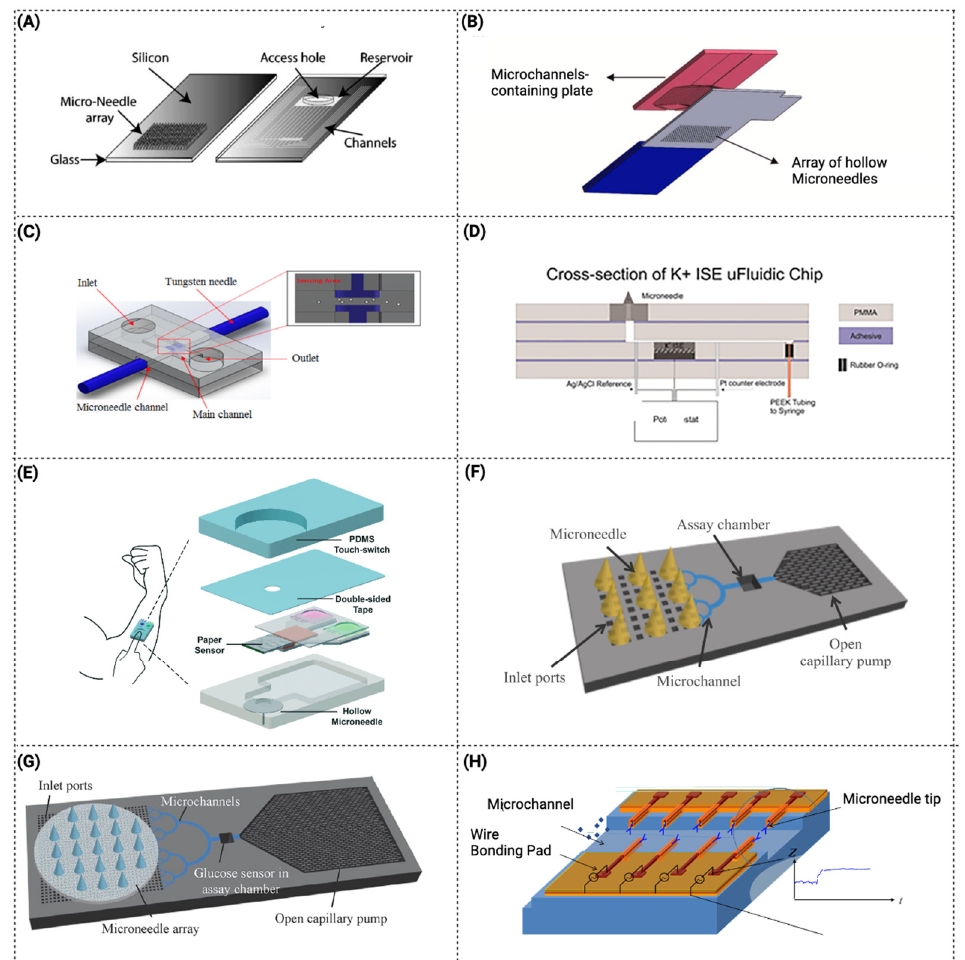
Figure 4. Schematic compilation of MN microfluidic devices for extraction and biomarker detection ( A ) Design of MN array. Reprinted from [81]. Copyright © 2023, with permission from Elsevier. ( B ) Integrated device for regular glucose measurement. Reprinted from [60]. Copyright © 2023, with